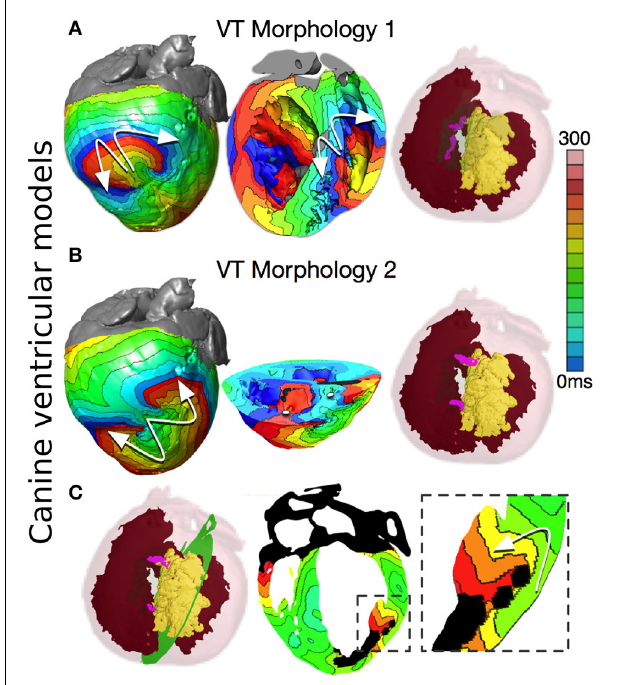
FIGURE 5 | Reentry morphologies during post-infarction ventricular tachycardia (VT) in a canine cardiac model. (A) VT morphology 1: Activation maps on the epicardium and in a long-axis cross-section of the ventricles, revealing figure-of-eight reentries on the epicardium, and on the right ventricular (RV) endocardium. VT is sustained by two I-type filaments (pink lines) located within the GZ with endpoints on the epicardium and RV endocardium. (Red: endocardial and epicardial surfaces, Yellow: scar surface, semi-transparent green: GZ) (B) VT morphology 2: Activation maps on the epicardium and in a short-axis cross-section of the ventricles, revealing figure-of-eight reentry on the epicardium, and two breakthroughs on endocardium (white dots). Reentry was organized around two I-type filaments with endpoints on the epicardium and scar (pink lines). (C) Activation map showing an apparent reentry around a scar distal from filaments. The overall VT morphology is similar to VT morphology 2 in Panel B . With permission from Arevalo et al.